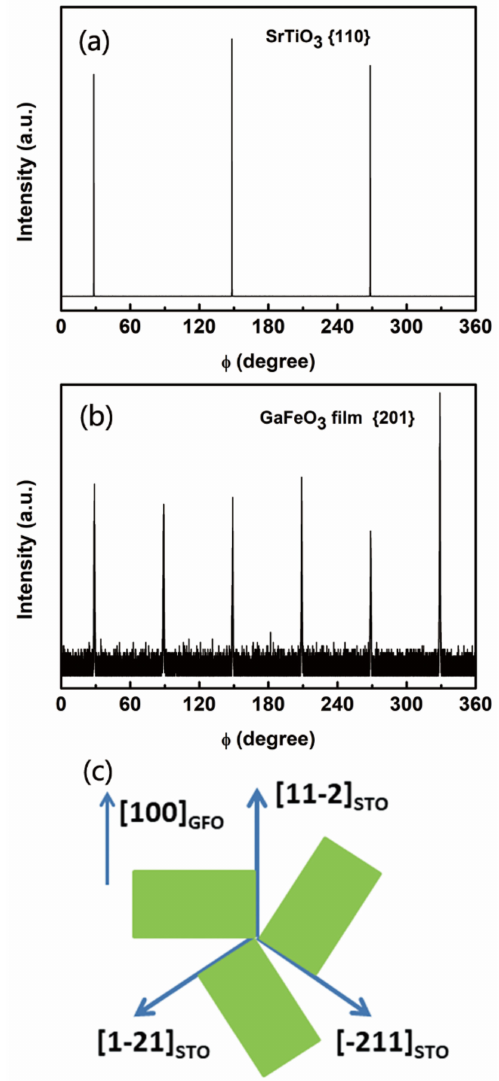
Figure 2. X-ray Φ scan patterns of ( a ) STO {110} substrate; ( b ) GFO {201} film, and ( c ) schematic presentation of the in-plane domain structure of GFO film on STO (111) substrate observed from the